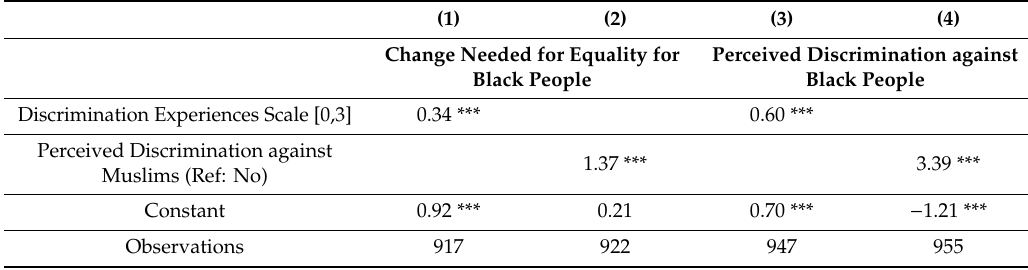
Table A1. Coe ffi cients from Logistic Regressions Predicting Solidarity with Black People.